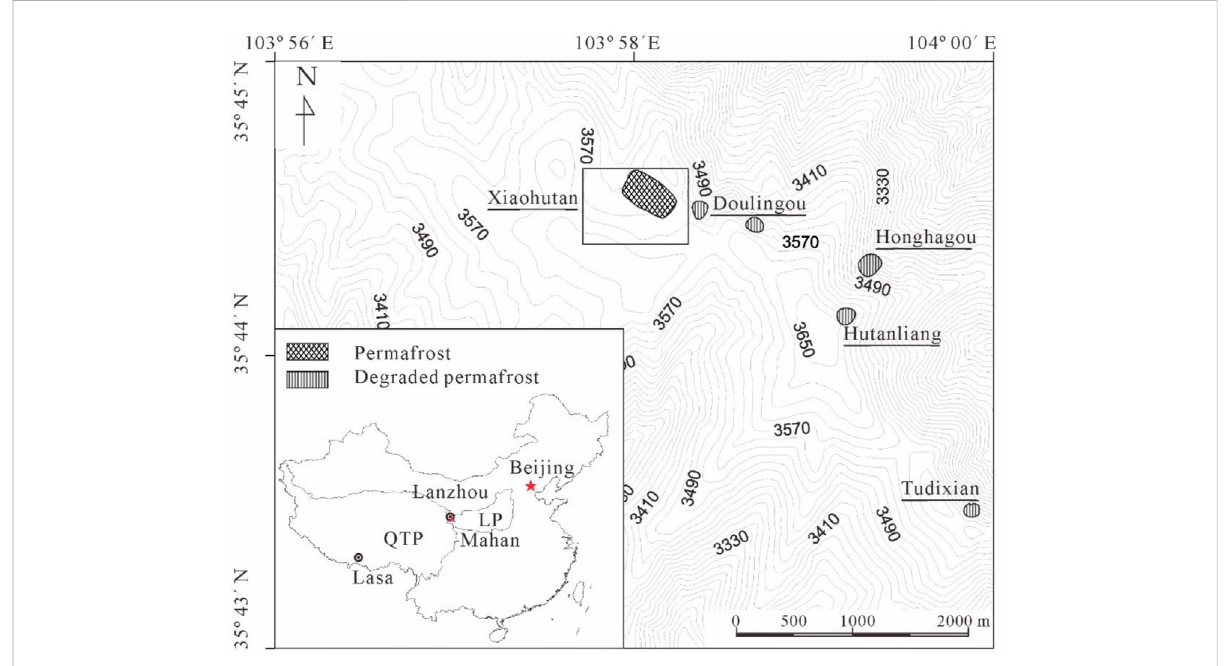
FIGURE 2 Location map of Mahan Mountain and the permafrost distribution. QTP indicates the Qinghai – Tibet Plateau; LP indicates the Loess